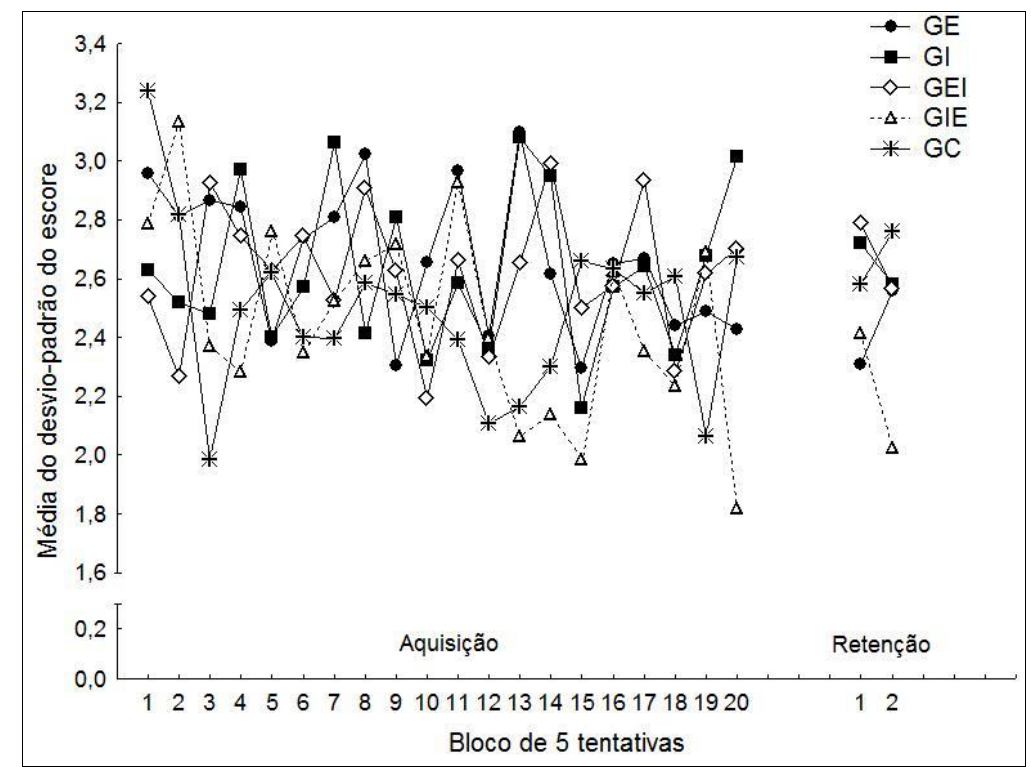
Figura 3. Média do desvio padrão do escore dos grupos na fase de aquisição e teste de retenção.